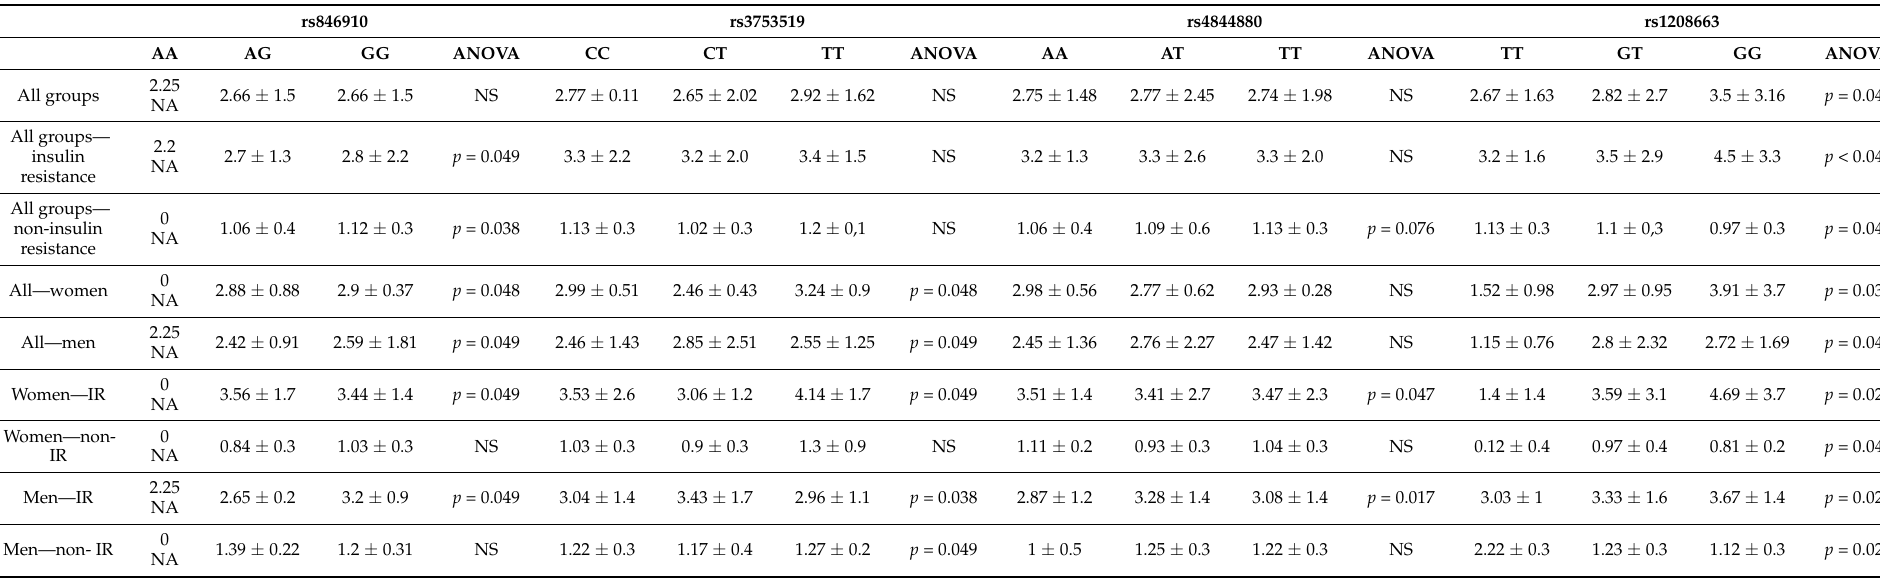
Table 4. The mean HOMA-IR values for the different polymorphisms of the type 1 HSD11B1 gene in the entire study group of subjects, in women with and without insulin resistance, and in men with and without insulin